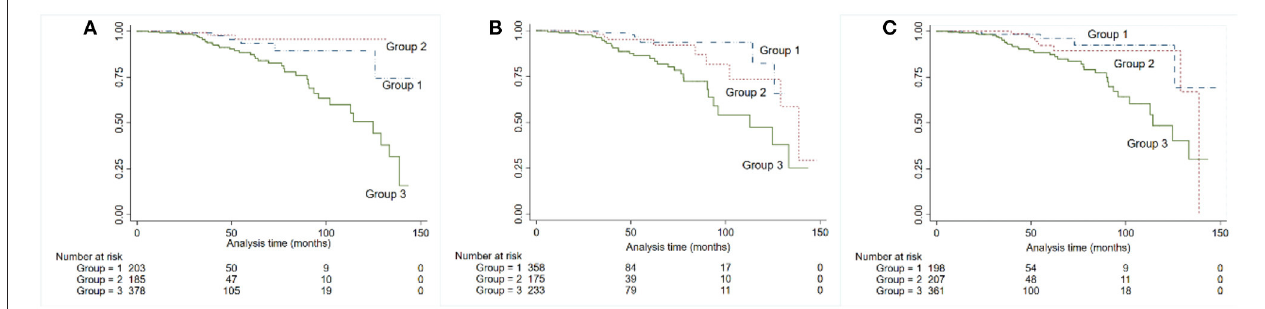
FIGURE 2 | Kaplan-Meier kidney survival curves for patients with IgA nephropathy, according to 24-h urine protein (A) , albumin-to-creatinine ratio (B) , and PCR (C) . Time zero was the time of kidney biopsy. The divisions among the three groups were based on the levels of proteinuria: group 1: ≤ 0.5, group 2: 0.5–1.0, group 3: ≥ 1.0.